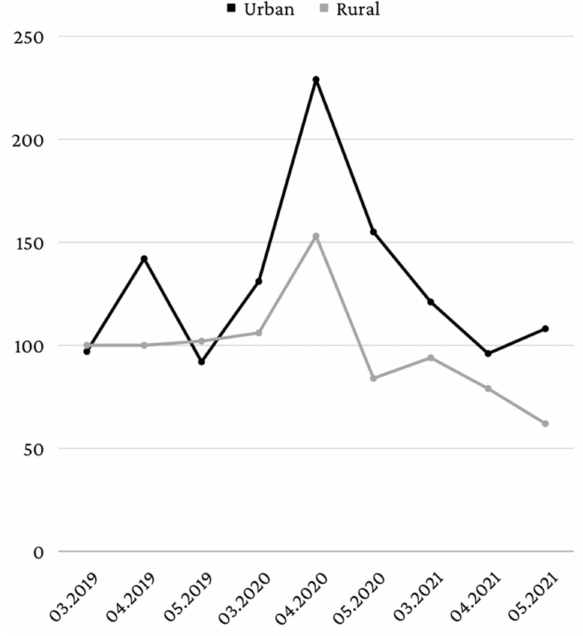
Figure 3. Distribution according to the living environment. Table 1. Distribution according to age